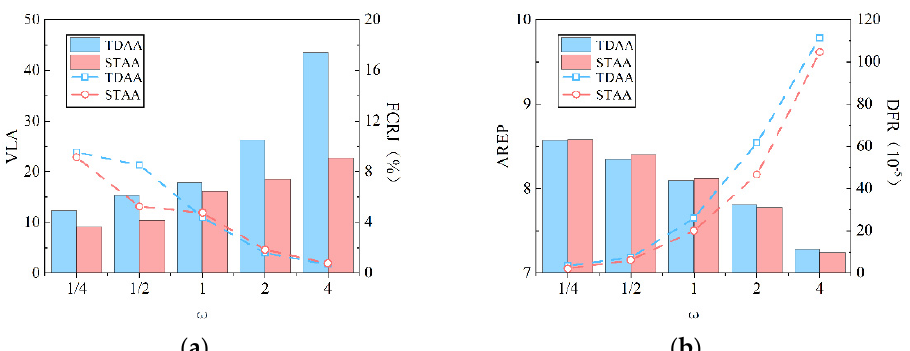
Figure 11. Schematic diagram of the performance comparison under different ω conditions between the TDAA [11] and the STAA. ( a ) The contrast between the VLA and FCRJ; ( b ) The contrast between the AREP and DVR. Table 2. Performance of the TDAA [11] and the STAA under different ω conditions.